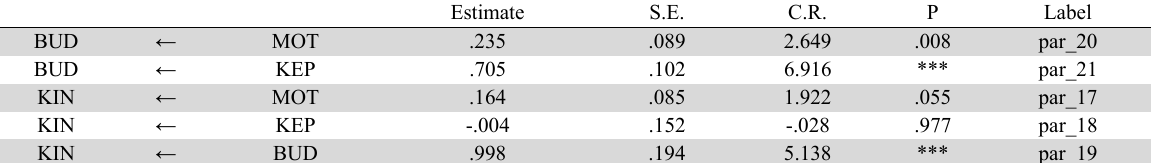
Regression Weight of Motivation (MOT), Leadership (KEP), Cultural Organization (BUD) and Per- formance (KIN) Estimate